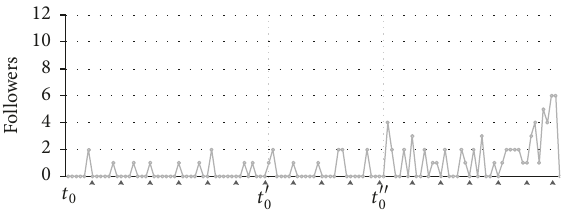
Figure 1: Regular ( 𝑡 0 ), slight ( 𝑡 󸀠 0 ), and permanent behavior ( 𝑡 󸀠󸀠 0 ).